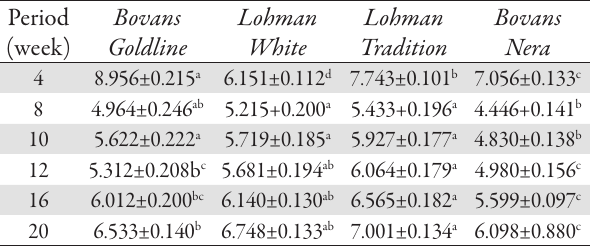
Tab. 3. Feed efficiency of growing pullets strains on the